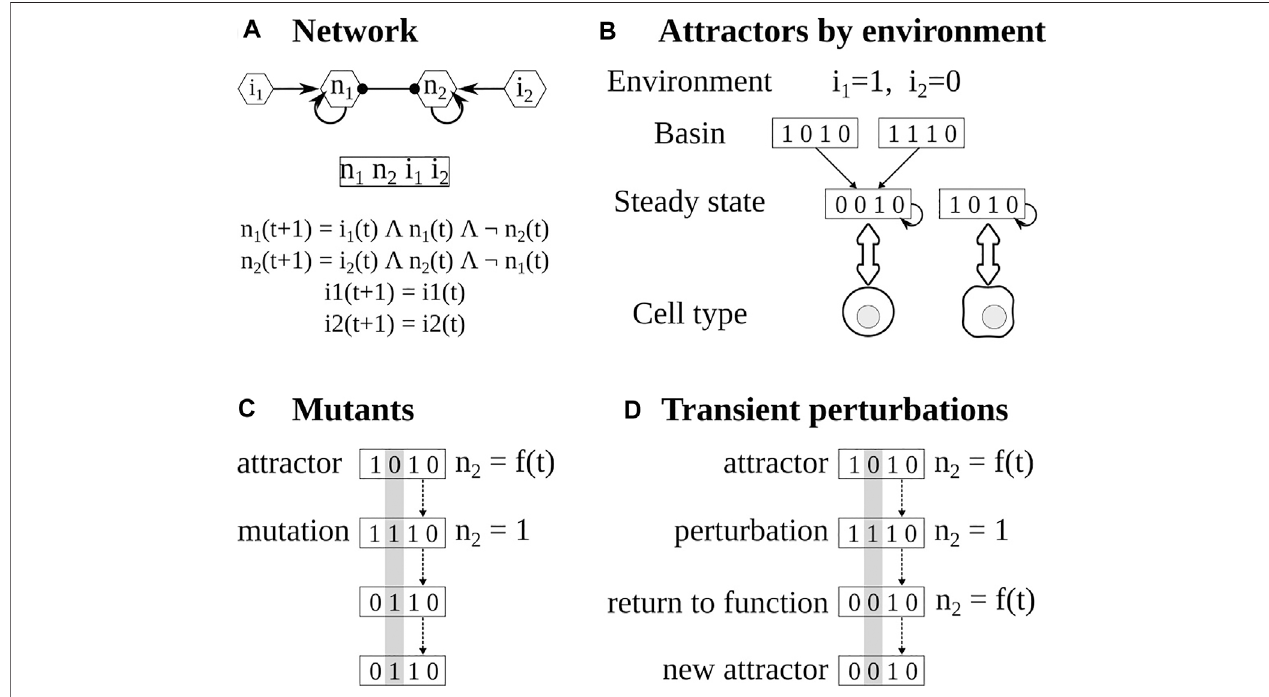
FIGURE 1 | Pipeline for the analysis of Boolean networks. (A) The network is constructed using available experimental information. The state of the network depends on the values of each node. The value of each node depends on its regulators. (B) The attractors of the network are calculated using BoolNet, the attractors depend on the inputs or environment and the functions. (C) Mutants are obtained by fi xing the value of the target node for the whole simulation. (D) In transient perturbations, the target node is changed (bit fl ip) for one time step, and then the perturbation is relaxed. Eventually, the network may stay, return to the original attractor, or reach a different